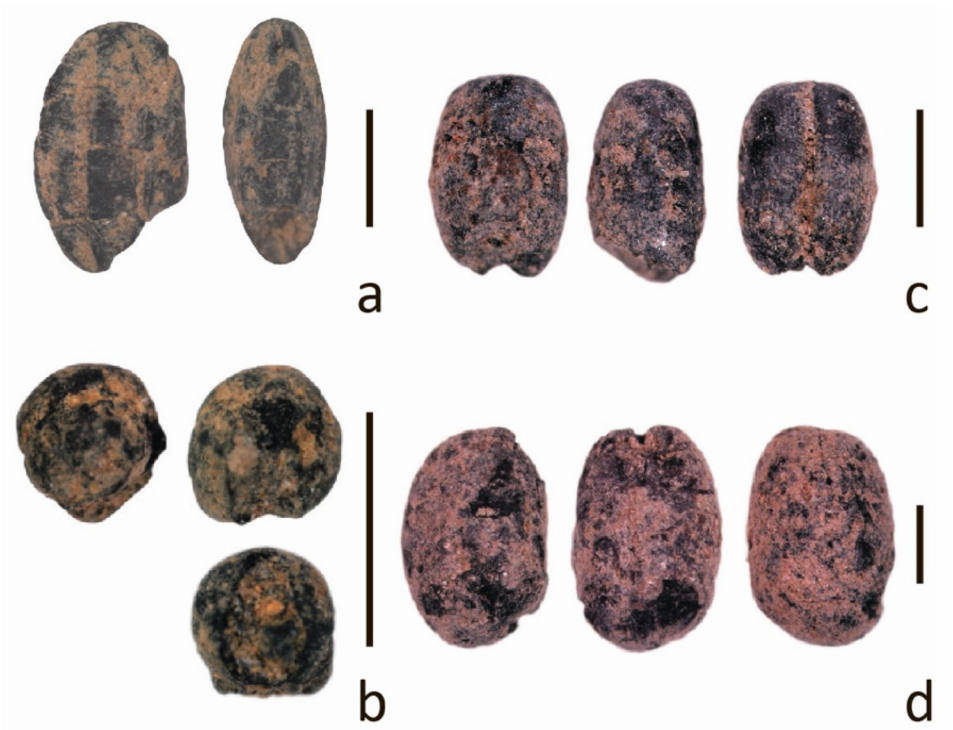
Figure 1. Excavated charred grains used for the analysis. A rice ( a ) and a foxtail millet grain ( b ) from dwelling no. 54–2 of the Jagae-ri site and a wheat ( c ) and an azuki bean grain ( d ) from dwelling no. 2 of the Yongheung-ri site. Scale bars = 2